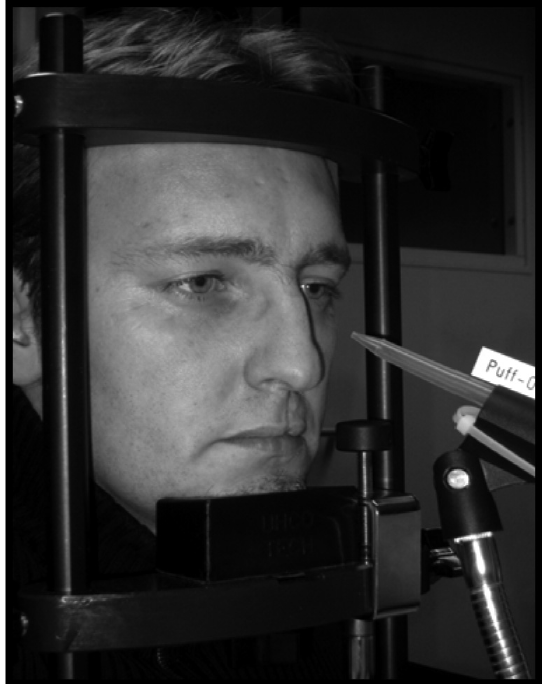
Fig. 1. Test situation: Participants placed their heads in a black metal